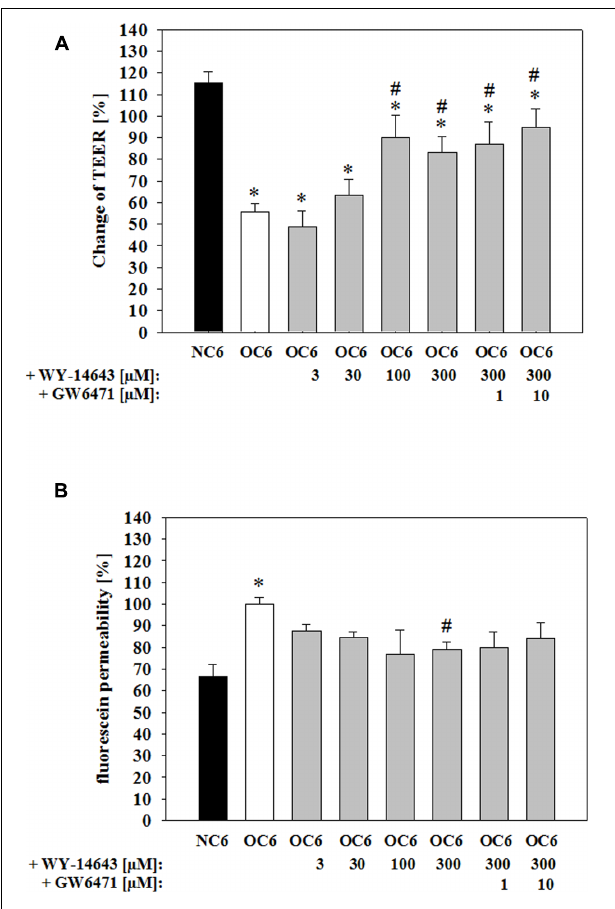
FIGURE 1 | Attenuation of barrier breakdown of cerebEND/C6 co-culture on Transwell inserts after 4 h oxygen/glucose deprivation (OGD) treatment by PPAR α agonist WY-14463 and PPAR α antagonist GW6471 – influence on transendothelial electrical resistance (TEER) (A) or fluorescein permeability (B) . Statistical significance was labeled with ∗ vs. NC6 and # vs. OC6 ( p < 0.05). Data are presented as means ± SD ( n =